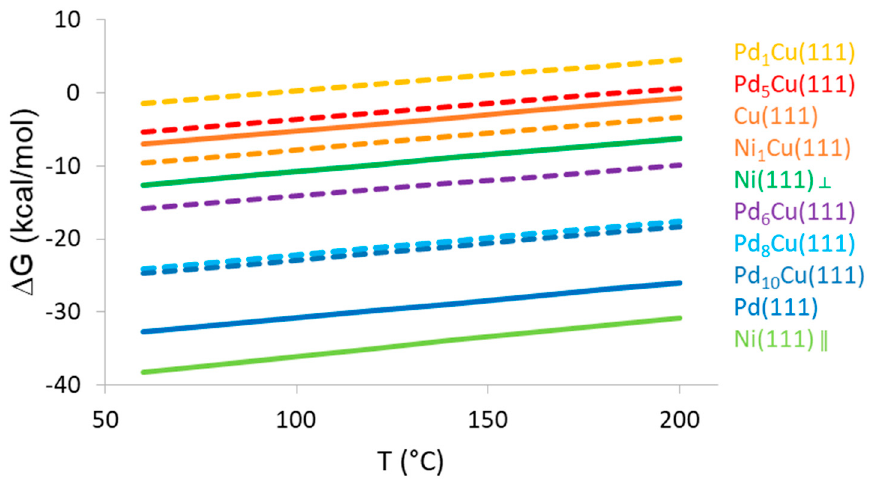
Figure 7. Gibbs free energies of adsorption on nitrobenzene on mono- and bimetallic catalyst models as a function of temperature.